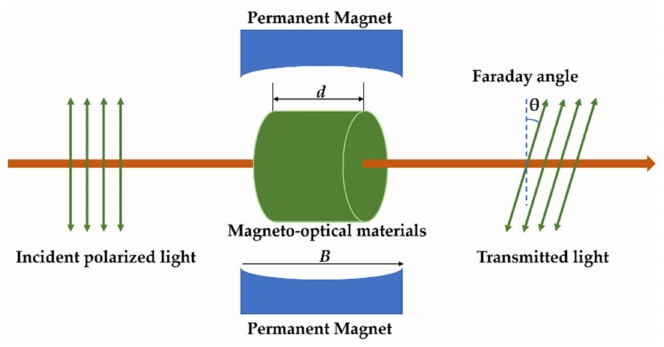
Figure 1. The graphic representation of the Faraday effect. Dy 2 O 3 undergoes phase transitions at high temperatures below the melting point [34], which makes the preparation of a Dy 2 O 3 single crystal troublesome, whereas Dy 2 O 3 polycrystalline ceramics can be synthesized at relatively low temperatures, at which Dy 2 O 3 keeps a cubic C-type structure. Extensive efforts have been made to fabricate Dy 2 O 3 ceramics. Dy 2 O 3 transparent ceramics were firstly reported in a patent in 2002 [26]. Then in 2011, Morale et al. [25] processed nanocrystalline Dy 2 O 3 ceramics using current activated pressure assisted densification (CAPAD), and the measured Verdet constant was above 300 rad/(T · m) at 632.8 nm. A series of optical ceramics based on (Dy x Y 0.95 − x La 0.05 ) 2 O 3 (x = 0.7, 0.85 and 0.9) were prepared by vacuum sintering with self-propagating high- temperature synthesis of submicron powders, and the dependence of the Verdet constant on the wavelength in the 400 nm–1940 nm range was measured in the report [27]. Additionally, the temperature dependences of the Verdet constant, and their approximations in the temperature range of 80 to 294 K and in the wavelength range of 405 to 1064 nm, with the <10% deviation from the experimental data, were reported in [35]. Slez á k et al. [28] also measured the temperature and wavelength dependence of the Verdet constant of Dy 2 O 3 transparent ceramics for the temperature ranging from cryogenic 20 K up to room temperature, 297 K, in the wavelength range starting from visible 0.6 µ m up to mid-infrared 2.3 µ m. Aung et al. [36] obtained optical grade Dy 2 O 3 ceramics, with an optical loss less than 0.1%/cm, by a pre-sintering and hot isostatic pressing treatment using ZrO 2 as a sintering